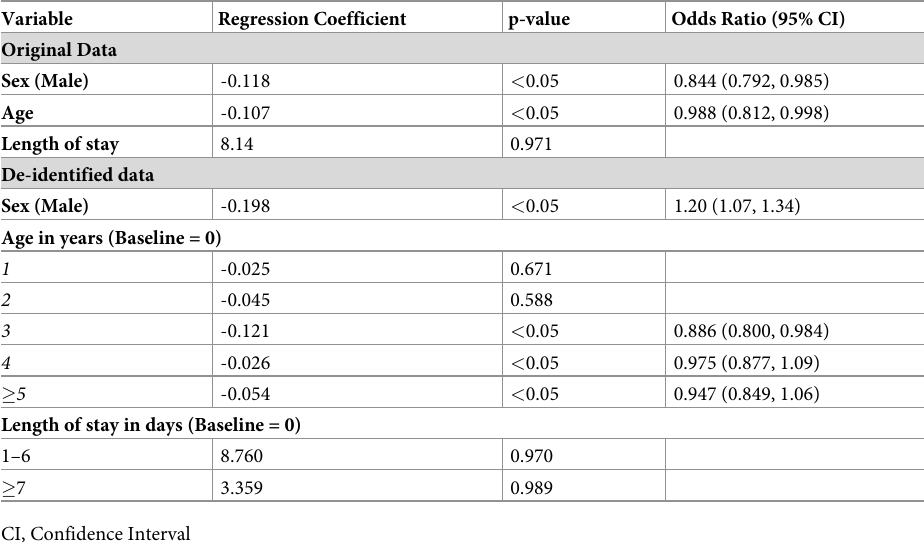
Table 9. Results from univariate logistic regression pre-and-post